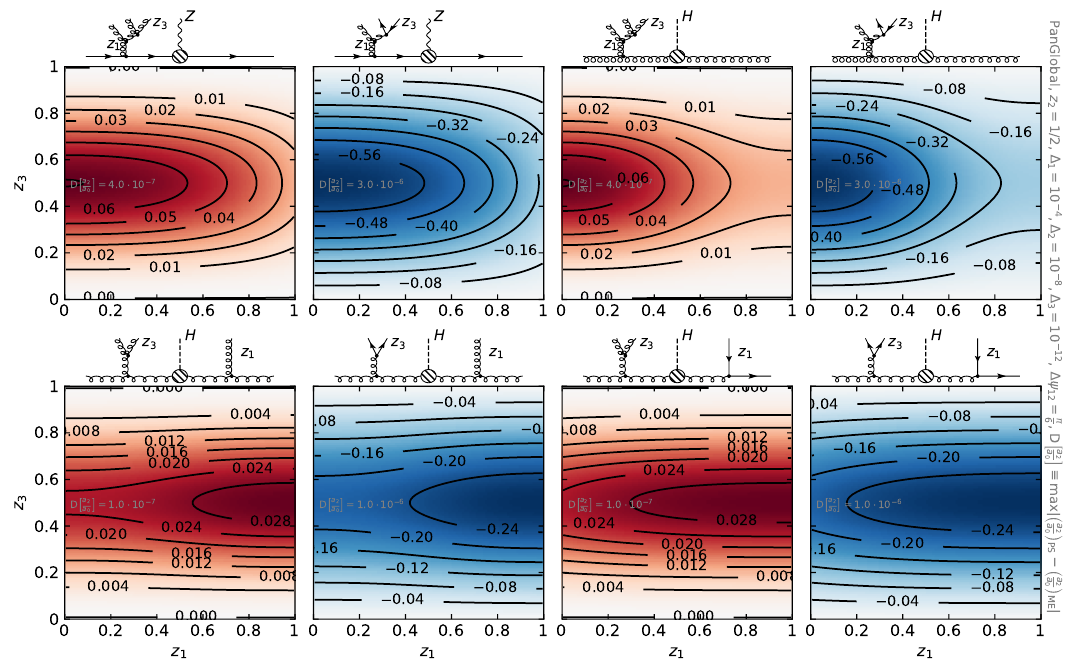
) for three collinear s , the third one z . We 1 3 = 0 . 5 , and its azimuthal angle 2